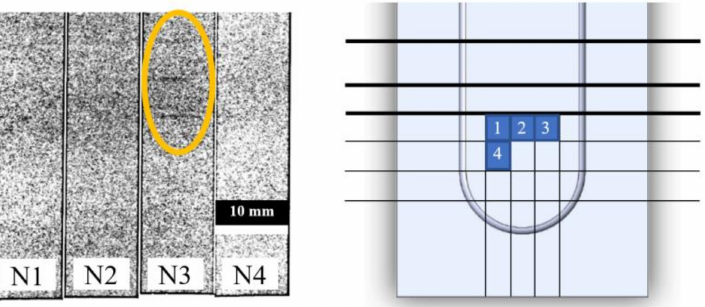
Figure 8. Transmission image of internal rods (ingot B); intense dark regions between every two layers are